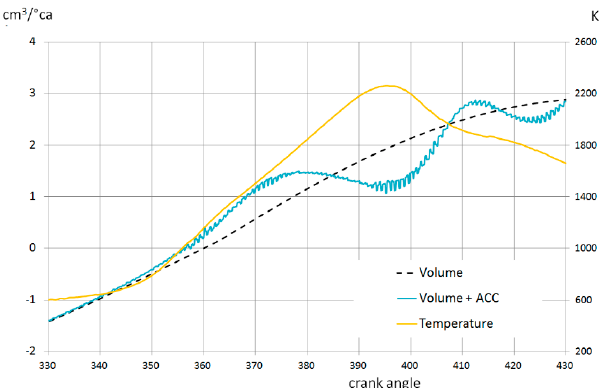
Figure 19. Temperature course and volume changes (1500 rpm, 10 bar).